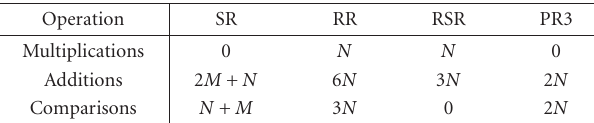
Table 2: Comparison of the number of operations for di ff erent re- sampling